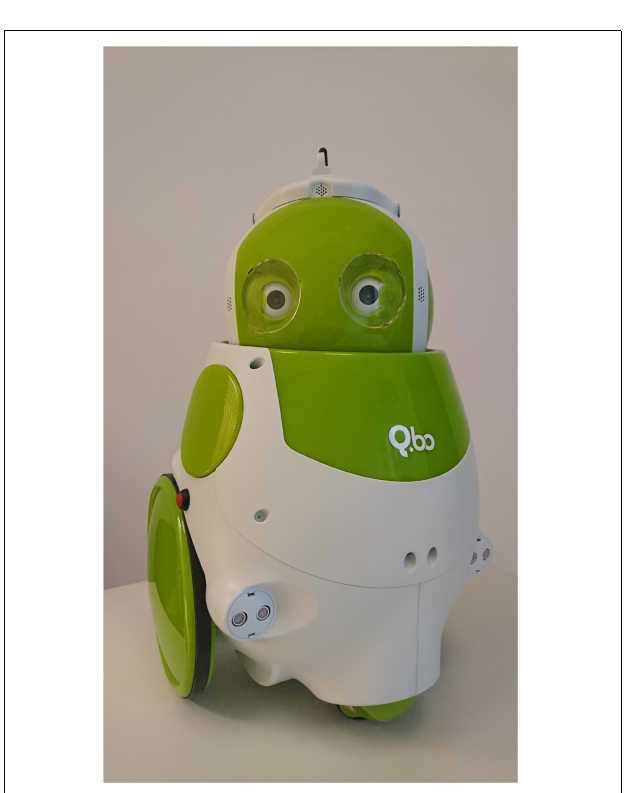
FIGURE 3 | TheCorpora’s QBo. The robot used in our experiment.